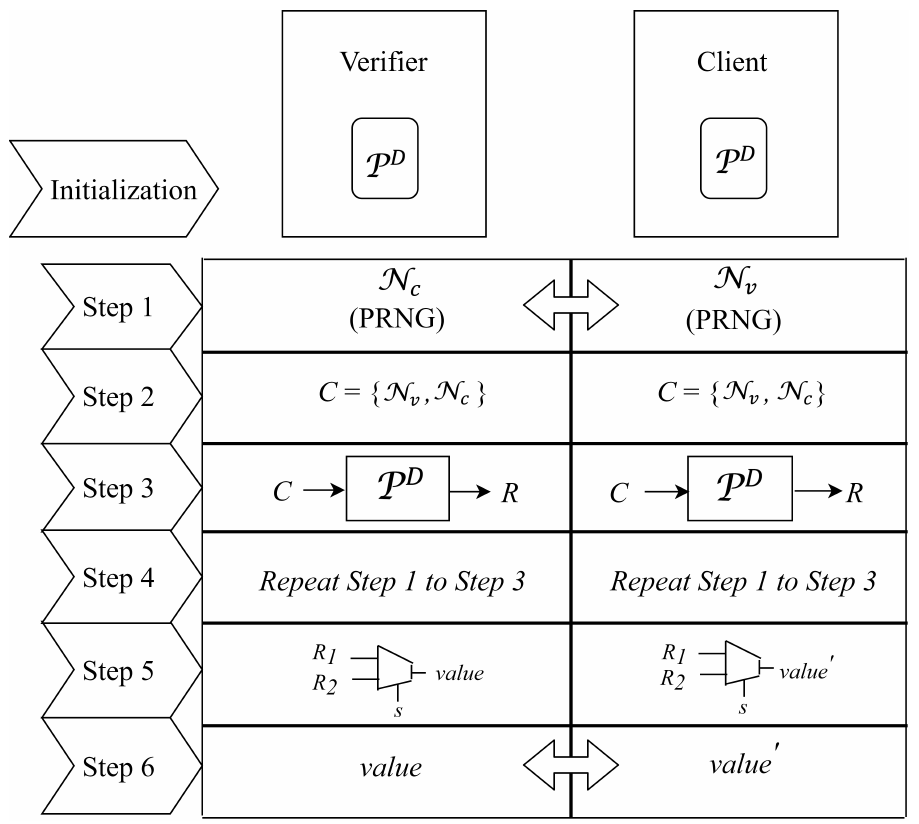
Figure 9. Steps of stochastic logic-based authentication